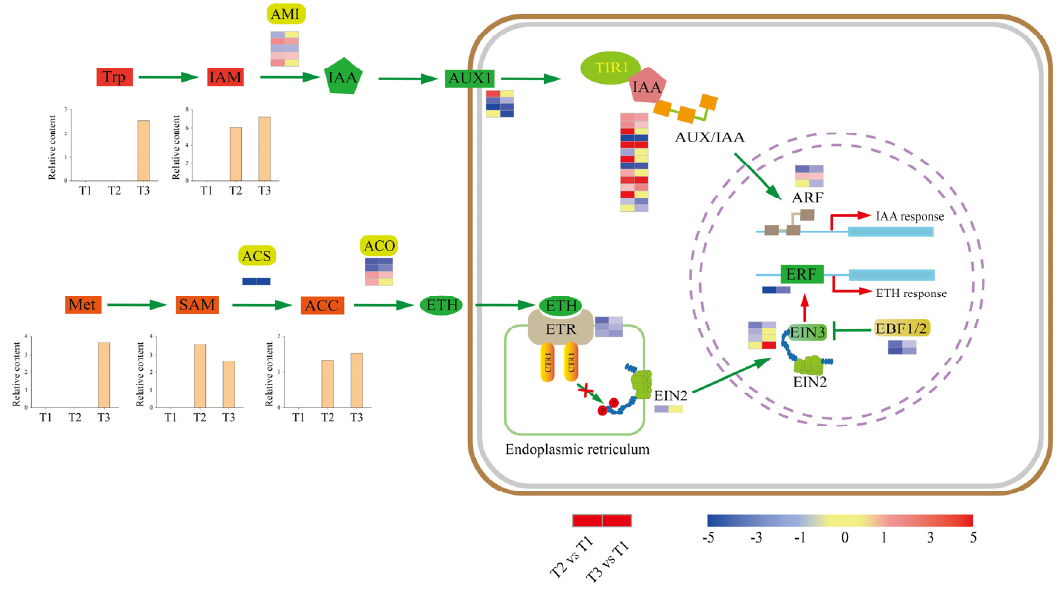
Figure 5. DEGs and DAMs in plant hormone biosynthesis and signal transduction. The expression heat maps from left to right are T2 vs. T1 and T3 vs. T1.